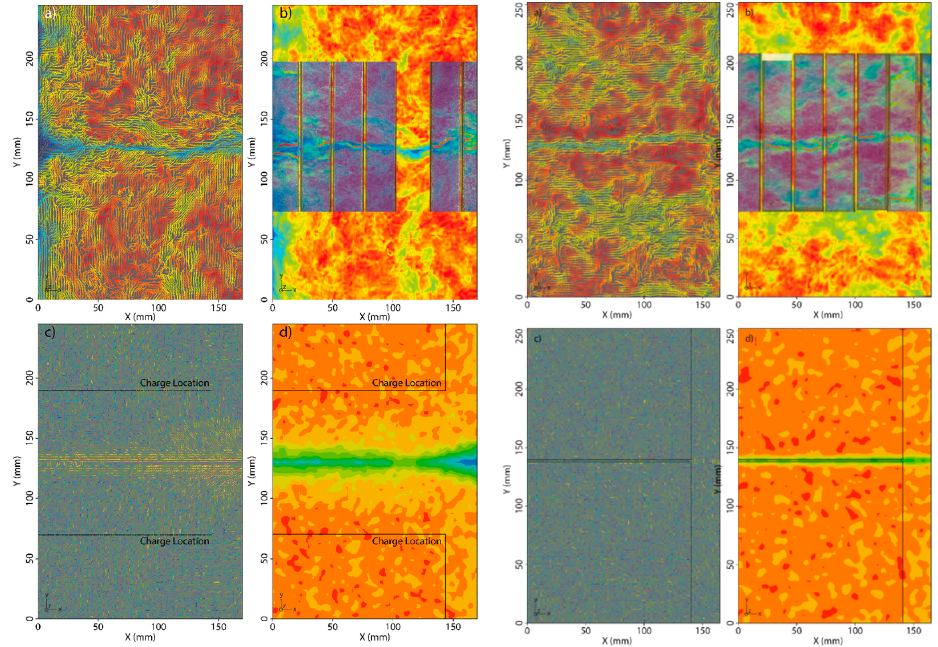
Figure 14. Comparing simulation with 3D-Timon with EC fibre angle and fibre volume fraction: ( right ) Flow ( left ) Butt.